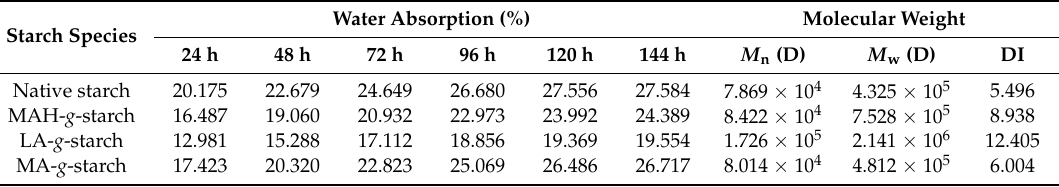
Table 2. Water absorption change and molecular weight of native starch and grafted starches.